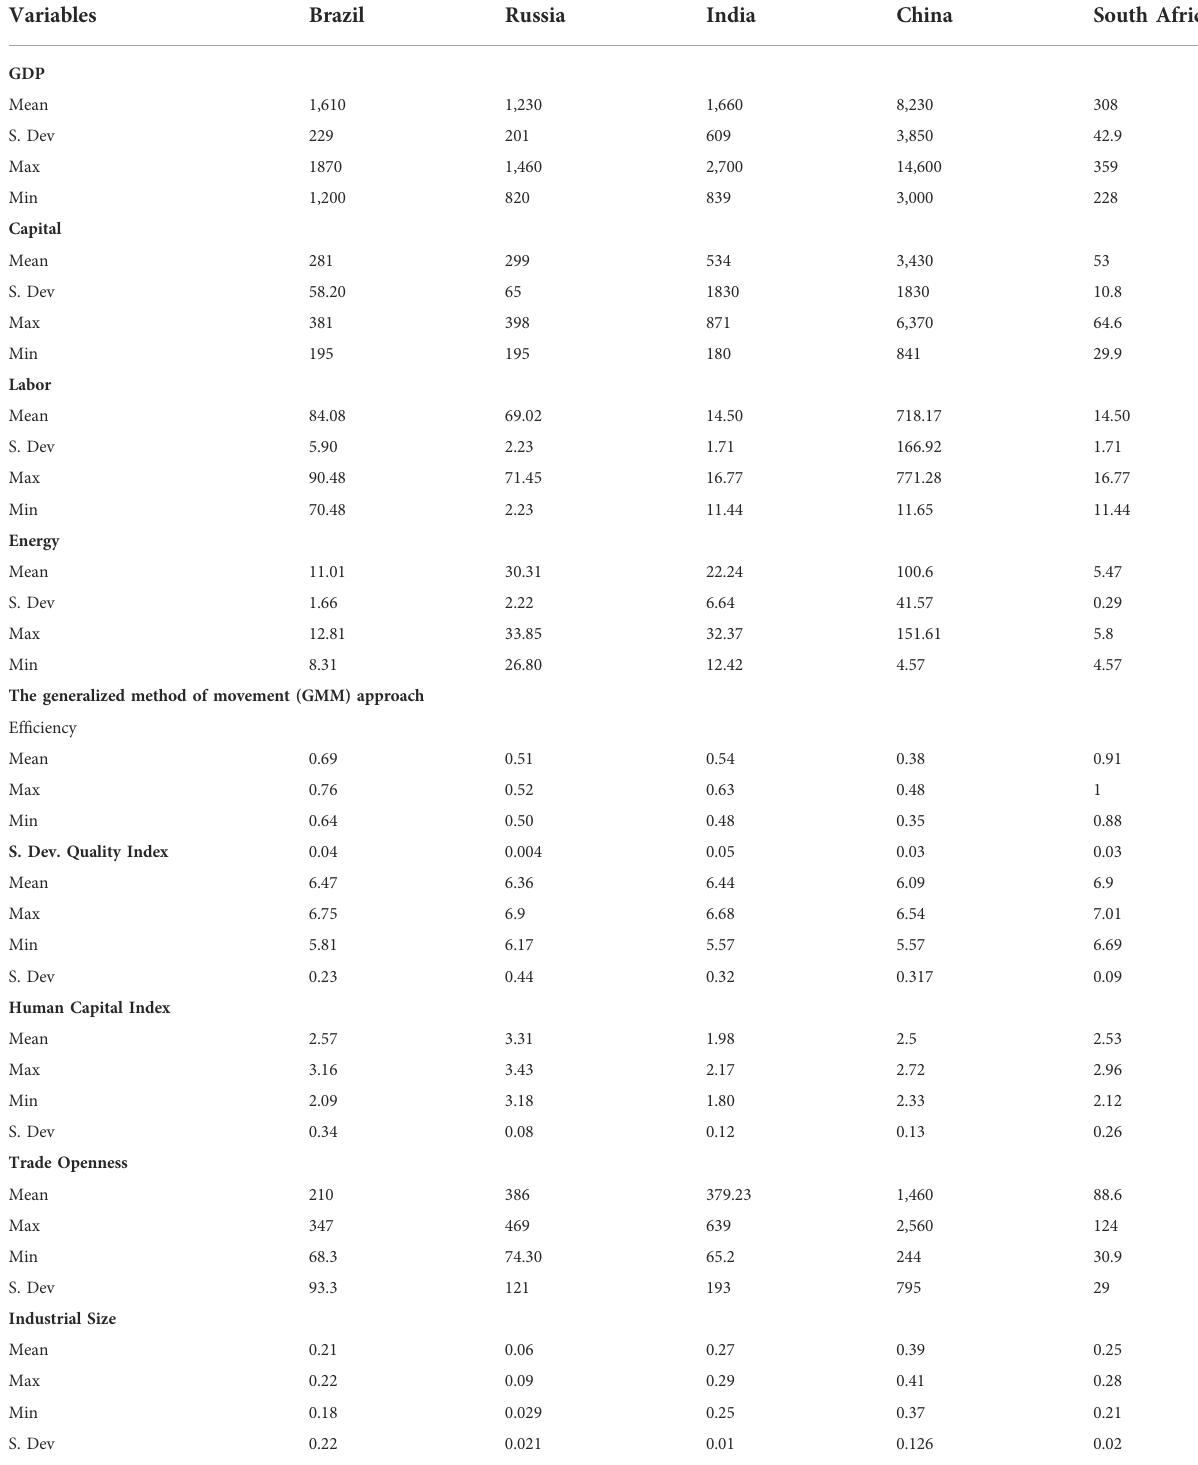
TABLE 2 Descriptive statistics of the